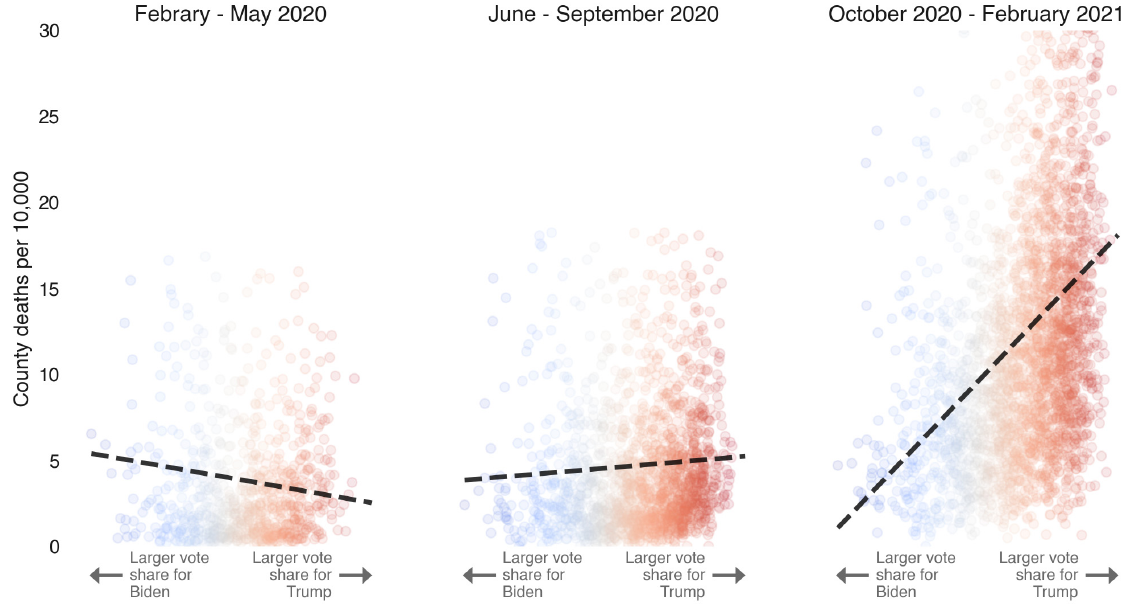
Fig 3. Evolution of COVID-19 deaths vs political leaning. COVID-19 attributed deaths (per 10,000) at the county level as a function of vote share in favor of J. Biden (Democratic) vs. D.J. Trump (Republican), 2020 presidential candidates, during the three periods of interest. The dashed black line on each figure indicated a line of best fit. Inspiration for this figure comes from David Leonhardt’s New York Times article, “Red COVID” [26].